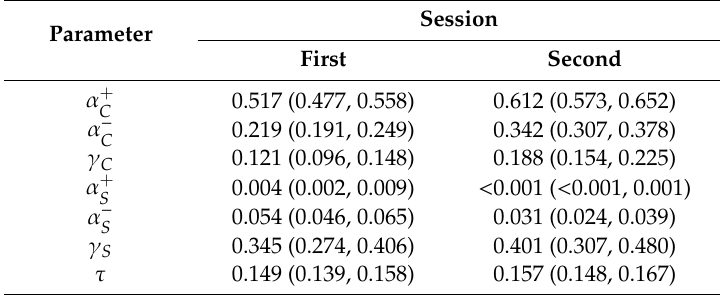
Table A5. Descriptive statistics of group-level posterior distributions of model parameters for first and second testing sessions (median with lower and upper quartiles in parentheses).